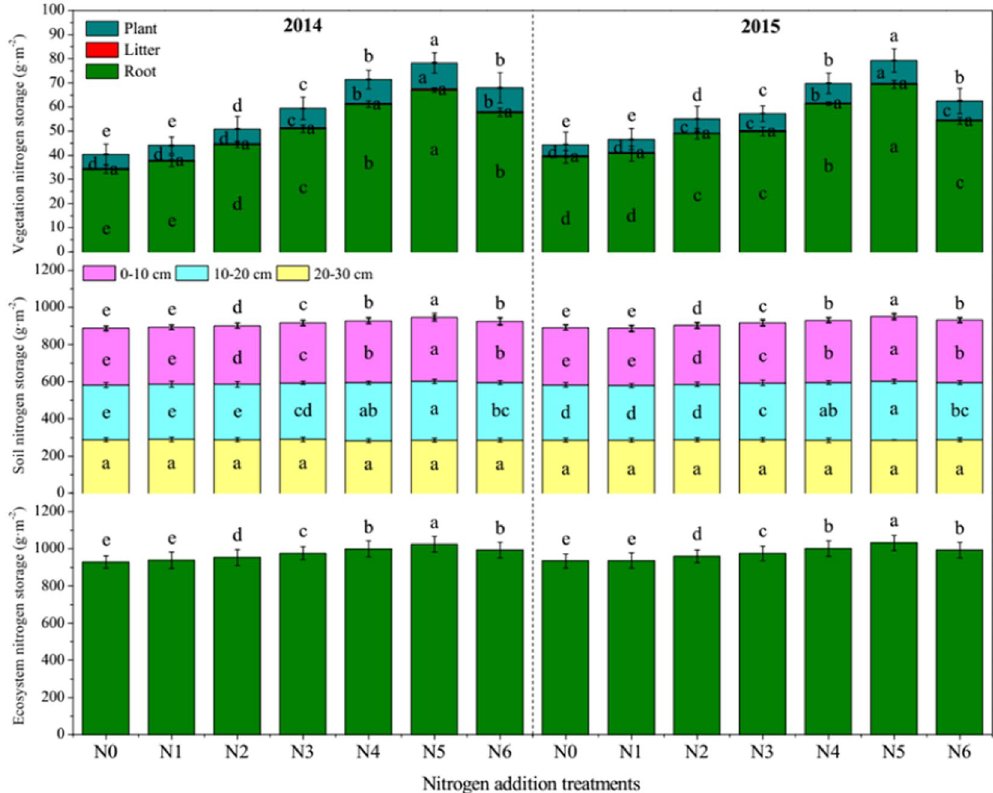
Figure 3. The total nitrogen storage in vegetation, soil and ecosystem in an alpine meadow under different nitrogen addition treatments. N0, N1, N2, N3, N4, N5 and N6 represent 0, 54, 90, 126, 144, 180 and 216 kg N ha − 1 yr − 1 , respectively. Different letters indicate significant differences at P < 0.05.